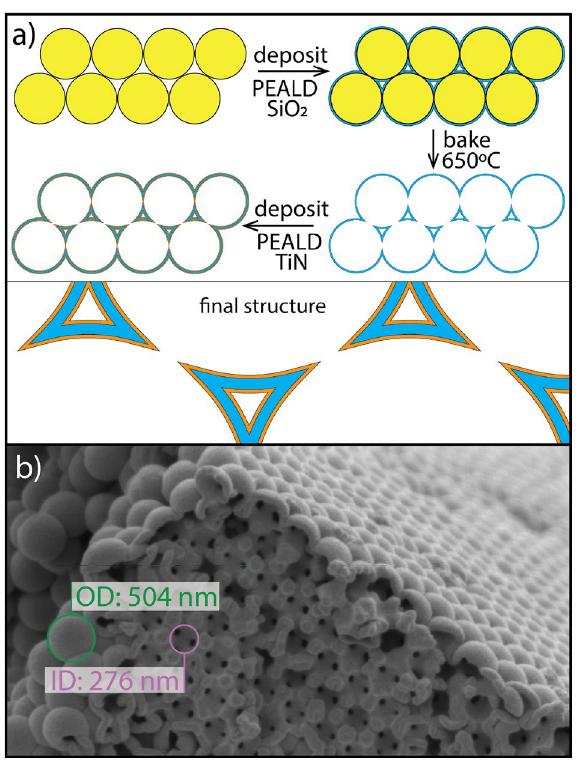
Figure 1. Inverse opal fabrication. Fabrication of TiN plasmonic, photonic, and conductive inverse opals. ( a ) Polystyrene beads in solution were evaporated onto a quartz slide and allowed to dry. These opals were partially infilled with a conformal layer of PEALD SiO 2 and then the organic component was removed by annealing. The remaining SiO 2 inverse opal was then partially infilled with a conformal layer of PEALD TiN. ( b ) A post- anneal scanning electron micrograph of an inverse opal coated with 47 nm of TiN shows the complex, periodic, and high surface area conductive inverse opal lattice. Starting with a 390 nm polystyrene sphere, a 10 nm SiO 2 conformal coating and a 47 nm TiN conformal coating will yield an outer diameter of 504 nm (in green) and an inner diameter of 276 nm (in